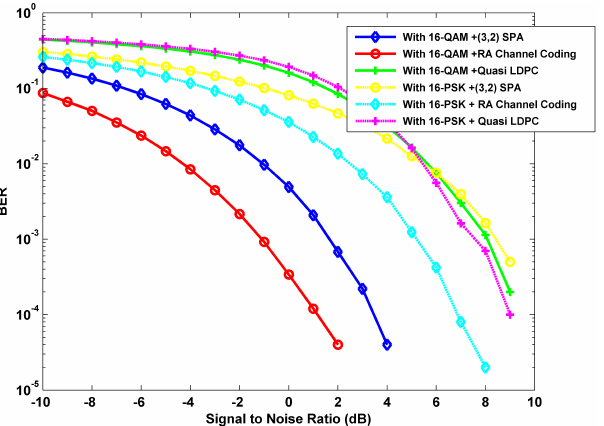
Figure 6. BER performance of the considered system with the utilization of various channel coding, higher − order digital modulation, and ZF signal detection techniques for user 2.